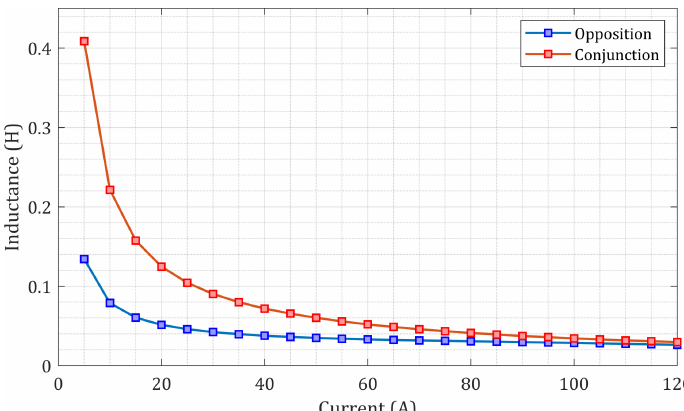
Figure 19. Phase inductance vs. current, calculated at opposite and conjunction